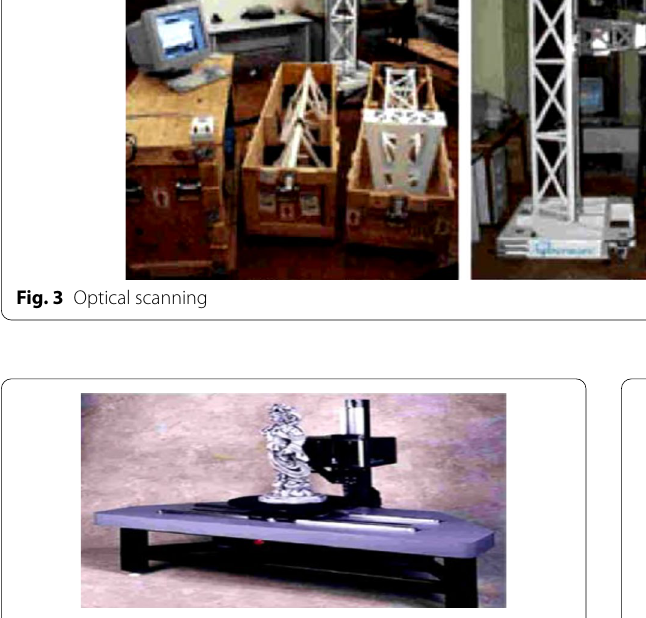
Fig. 5 The robot dedicated to digital